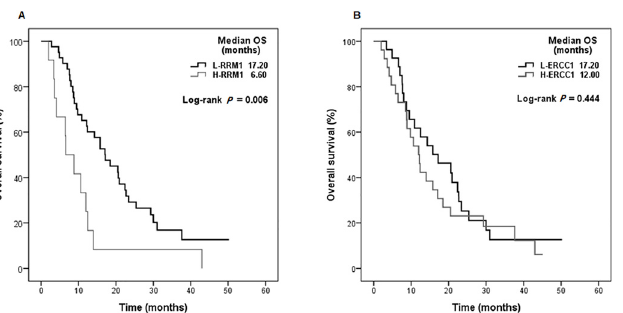
Fig 3. Overall survival of patients according to biomarker expression for (A) ribonucleotide reductase subunit M1 (RRM1), (B) excision crosscomplementing gene-1 (ERCC1).